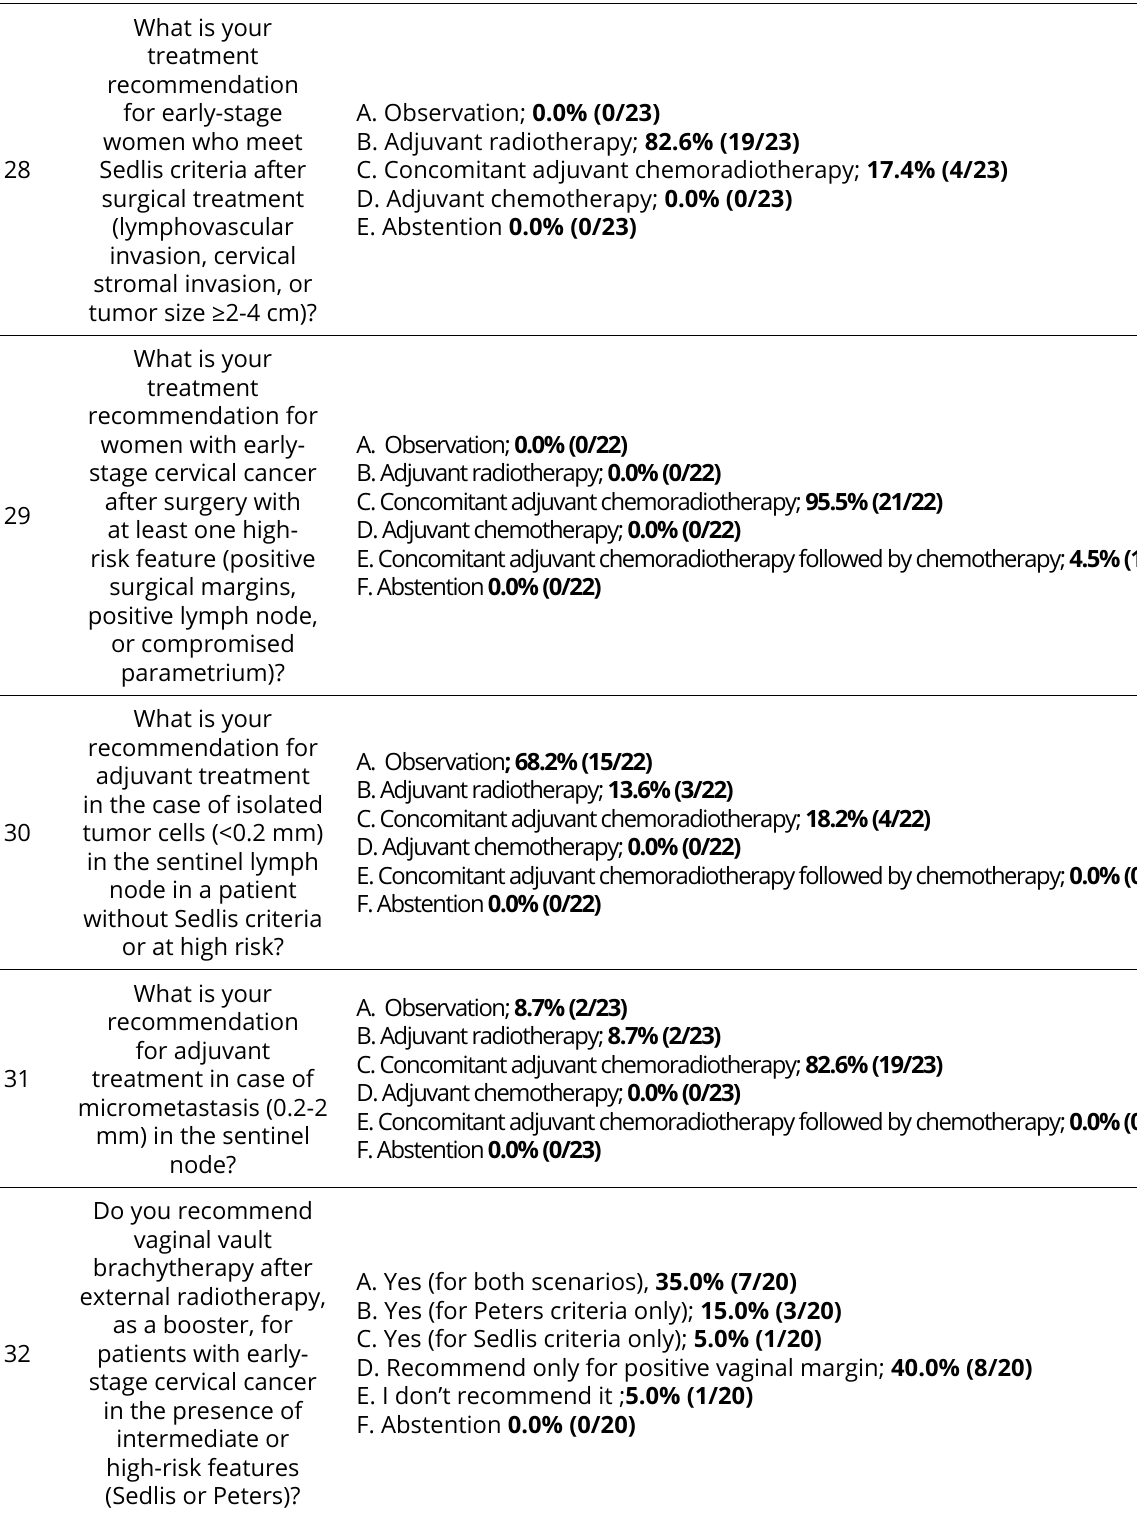
Key issues in the management of cervical cancer: consensus recommendations by a Brazilian expert panel Brazilian Journal of